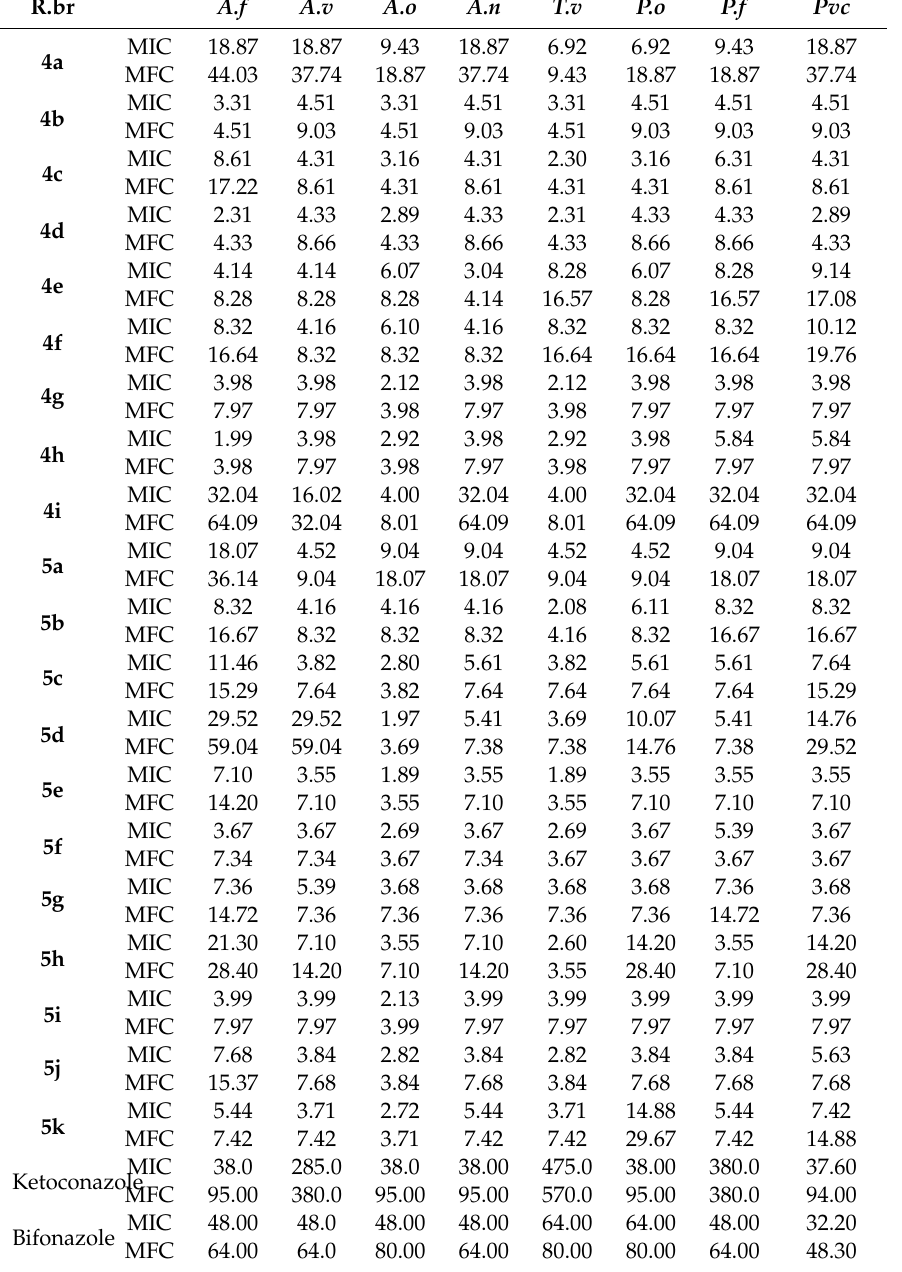
Table 3. Antifungal activity of compounds ( µ M × 10 − 2